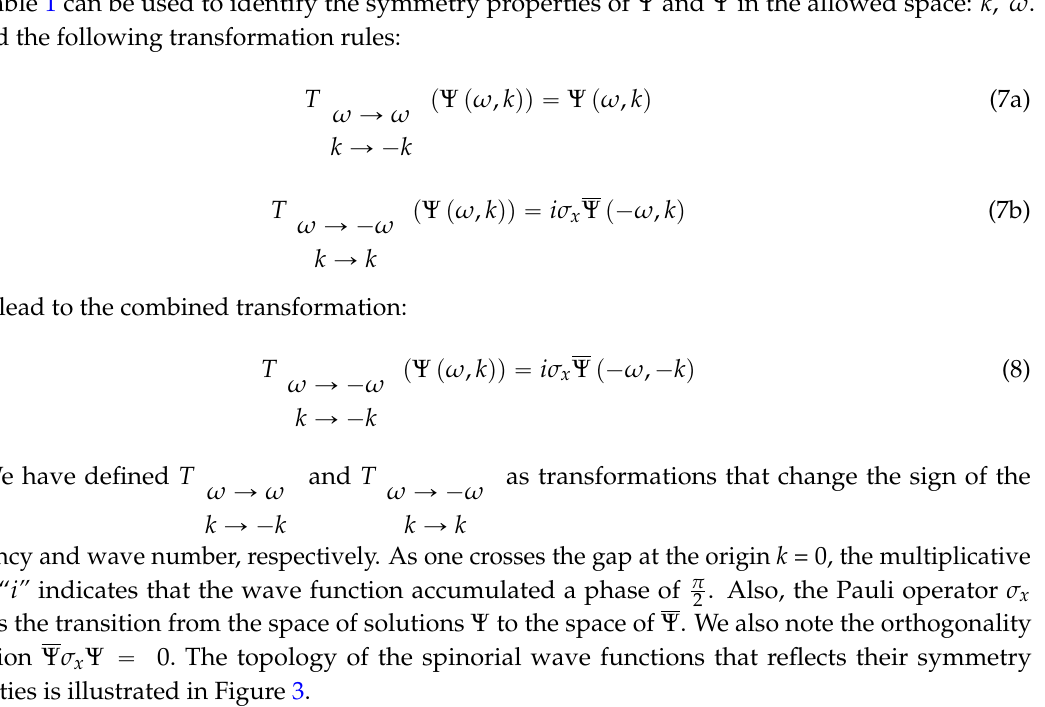
Table 1 can be used to identify the symmetry properties of Ψ and Ψ in the allowed space: k , ω